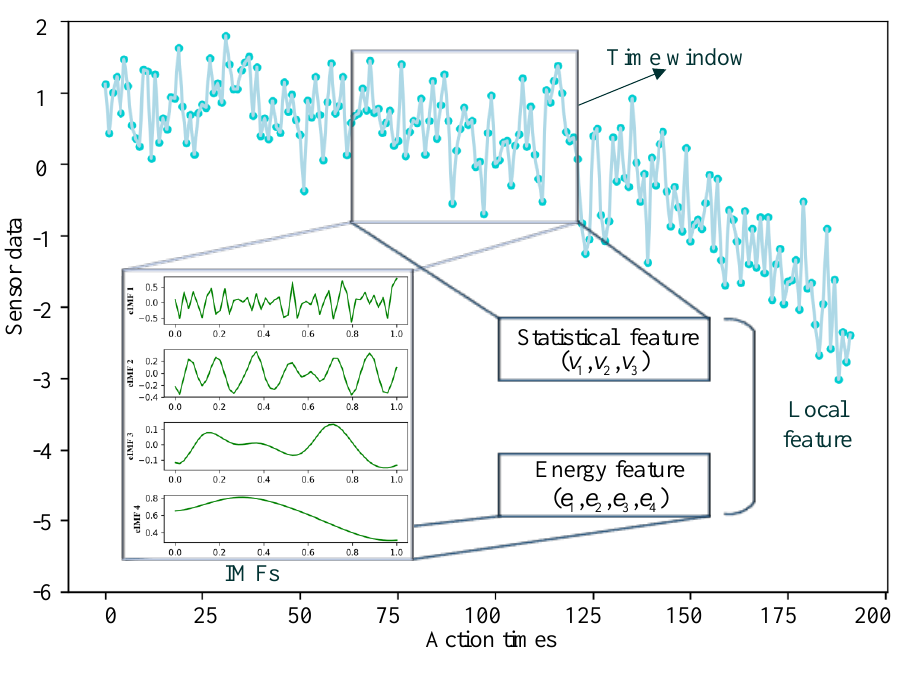
Figure 3. The process of local feature extraction based on a sample from NASA’s Prognostics Repository. The local features include statistical features (average value v 1 , variance v 2 and skewness v 3 ) and the energy features ( e 0 , e 1 ... e z ) which are calculated based on intrinsic mode function (IMF)